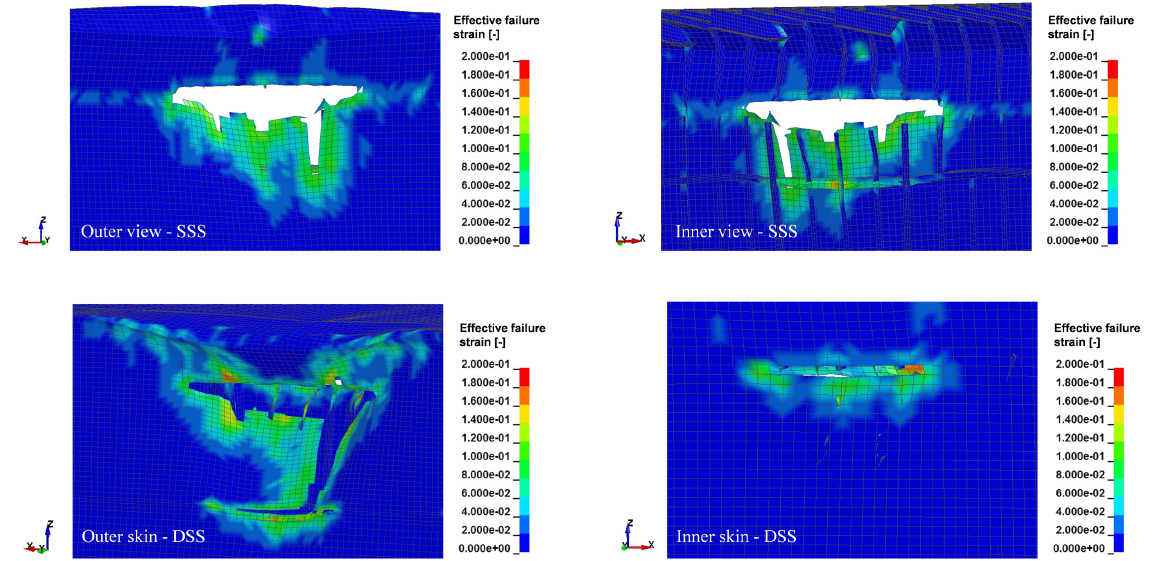
Figure 6: Structural failure on the single and double skin structures: penetration to the side shell with the applied material I – Grade A with σ Y = 370 MPa.